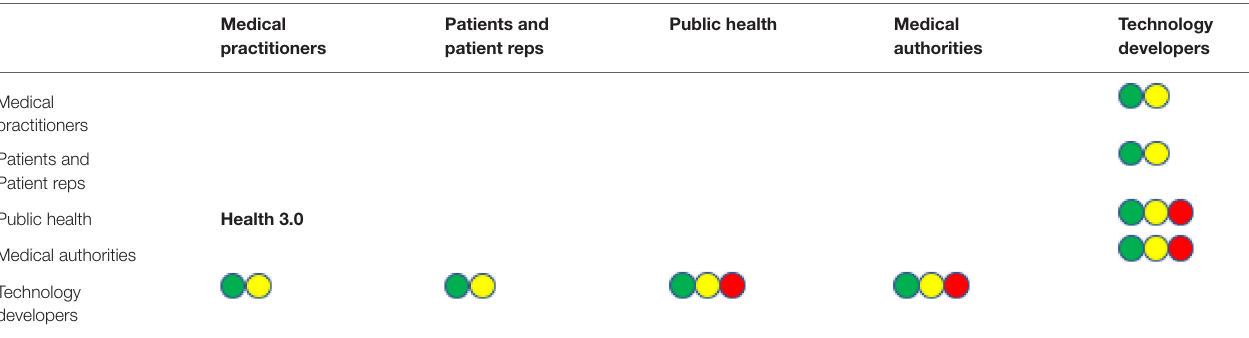
TABLE 2 | Health 4.0 trust matrix, yellow green and red dots indicate implications for uses cases 1 (supervised exercise), 2 (ECG diagnosis) and 3 (medical education),